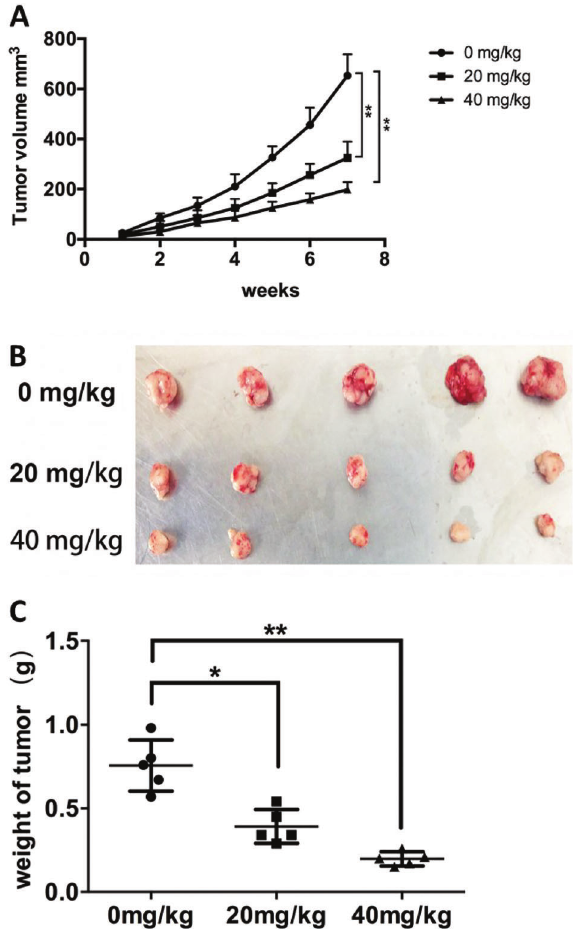
Figure 3. Cantharidin inhibited tumor growth in a xenograft model of breast cancer. A , Tumor volumes of xenograft model of breast cancer using MDA-MB-231 cells. The mice from each group were injected with cantharidin (20 or 40 mg/kg) daily for 3 weeks. The mice without cantharidin injection were used as control. B , Dissected tumors from each group of mice 7 weeks after inoculation. C , Weight of dissected tumors. Data are reported as means ± SD. *P o 0.05; **P o 0.01 ( t